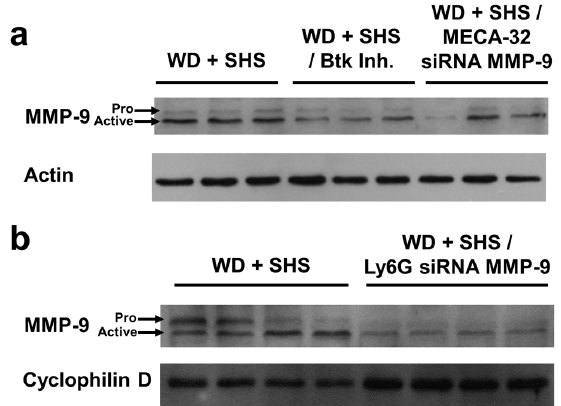
Figure 9. Levels of MMP-9 in lung homogenates ( a ). Western blot from ApoE − / − mice fed WD and exposed to SHS only (WD + SHS), with Btk inhibitor treatment (WD + SHS/Btk Inh.), or treated with endothelial cell targeted siRNA for MMP-9 (WD + SHS/MECA-32 siRNA MMP-9). Three mice per group were analyzed ( b ). Western Blot from ApoE − / − mice fed WD and exposed to SHS only (WD + SHS) or treated with neutrophil targeted siRNA (WD + SHS/Ly6G siRNA MMP-9). Four animals per group were analyzed.